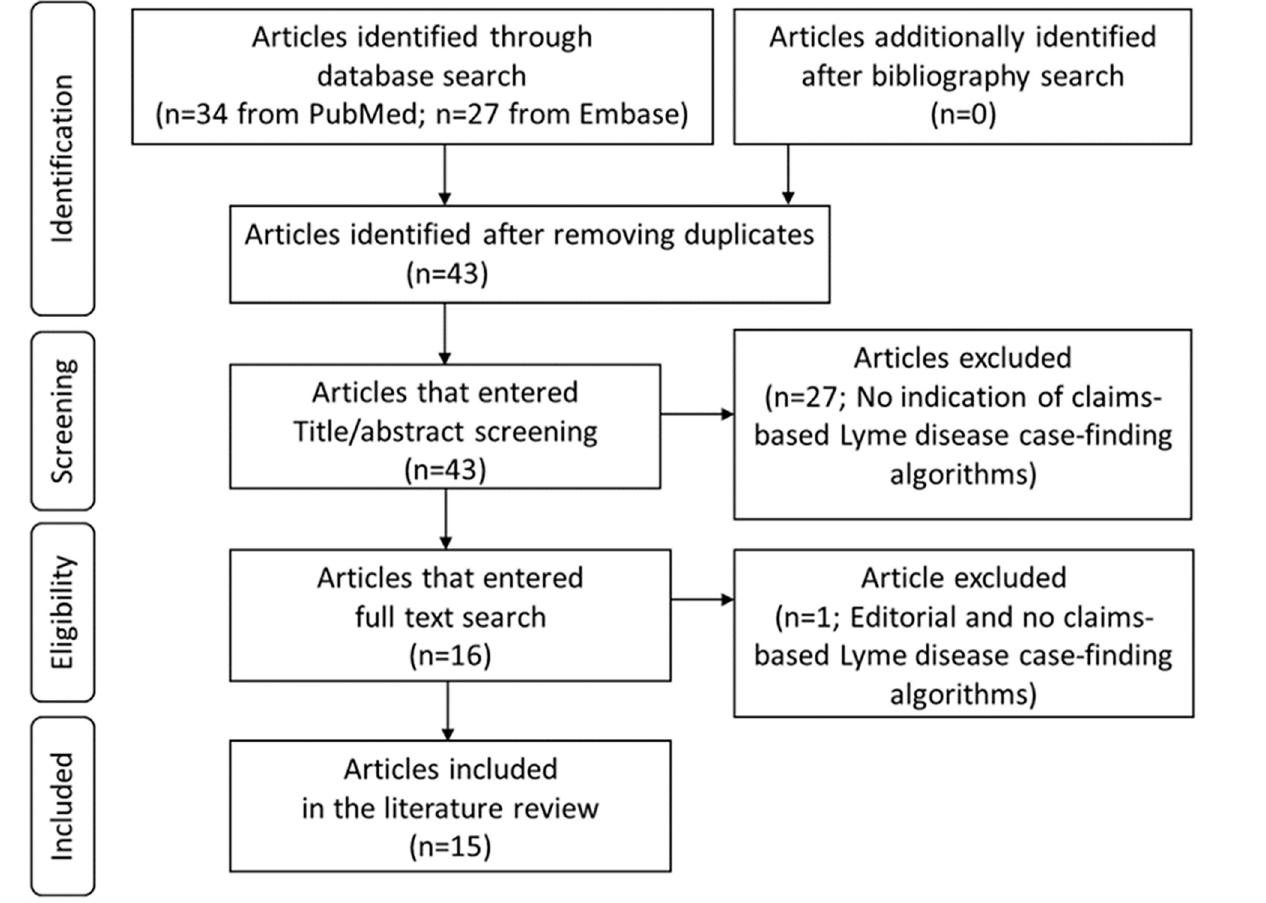
Fig 1. Search and selection of articles for the literature review on the US claims-based Lyme disease case-finding algorithms published in English since 2000. Reference for the flow diagram: Preferred Reporting Items for Systematic Reviews and Meta-Analyses (PRISMA) Statement (https://doi.org/10.1371/